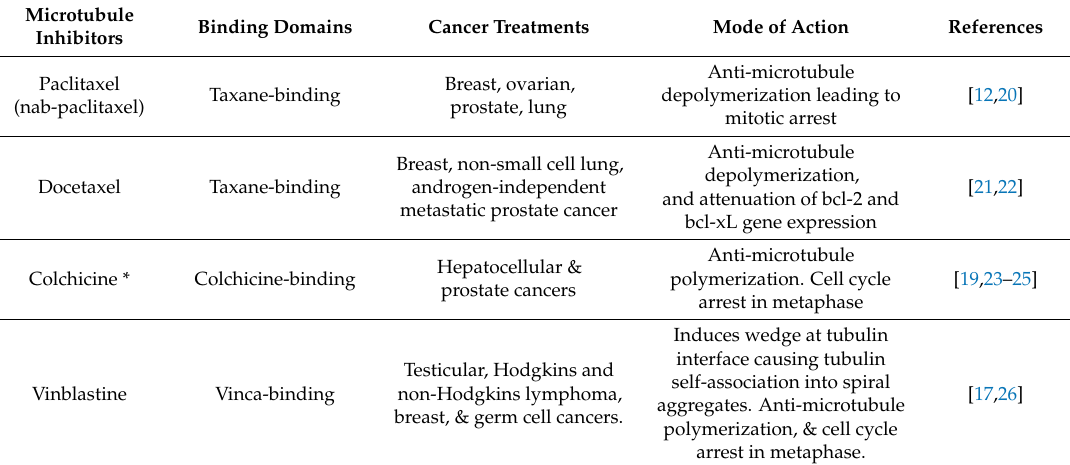
Table 1. Summary of well-known tubulin